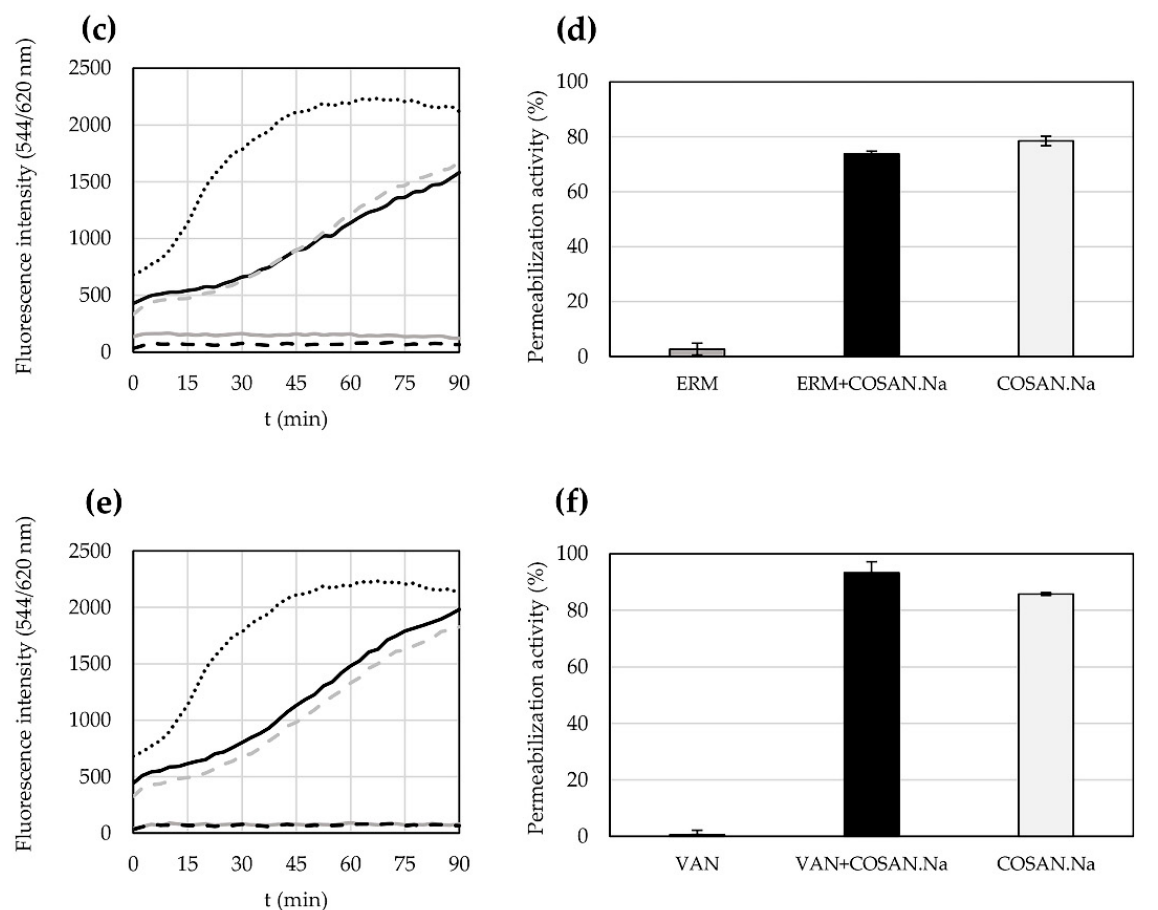
Figure 2. Cytoplasmic membrane permeabilization of Staphylococcus epidermidis CNCTC 5671 cells by tetracycline (TET), erythromycin (ERM), vancomycin (VAN), sodium salt of cobalt bis-dicarbollide (COSAN.Na) or their combination determined as fluorescence intensity of uptaken propidium iodide (PI). ( a ) PI uptake by cells affected by TET 4.5 µ g/mL, COSAN.Na 2.24 µ g/mL or TET 4.5 µ g/mL + COSAN.Na 2.24 µ g/mL; ( b ) permeabilization activity of TET 4.5 µ g/mL, COSAN.Na 2.24 µ g/mL or TET 4.5 µ g/mL + COSAN.Na 2.24 µ g/mL; ( c ) PI uptake by cells affected by ERM 0.3 µ g/mL, COSAN.Na 1.68 µ g/mL or ERM 0.3 µ g/mL + COSAN.Na 1.68 µ g/mL; ( d ) permeabilization activity of ERM 0.3 µg/mL, COSAN.Na 1.68 µg/mL or ERM 0.3 µg/mL + COSAN.Na 1.68 µg/mL; ( e ) PI uptake by cells affected by VAN 0.15 µg/mL, COSAN.Na 2.24 µg/mL or VAN 0.15 µg/mL + COSAN.Na 2.24 µg/mL; ( f ) permeabilization activity of VAN 0.15 µg/mL, COSAN.Na 2.24 µg/mL or VAN 0.15 µg/mL + COSAN.Na 2.24 µg/mL; black dotted lines indicate positive control (cell sus- pension mixed with octenidine dihydrochloride); black dashed lines indicate negative control (cell suspension in phosphate-buffered saline); grey lines indicate appropriate antibiotic at described concentrations; grey dashed lines indicate COSAN.Na at described concentrations; black lines indi- cate combination of appropriate antibiotic and COSAN.Na at described concentrations.